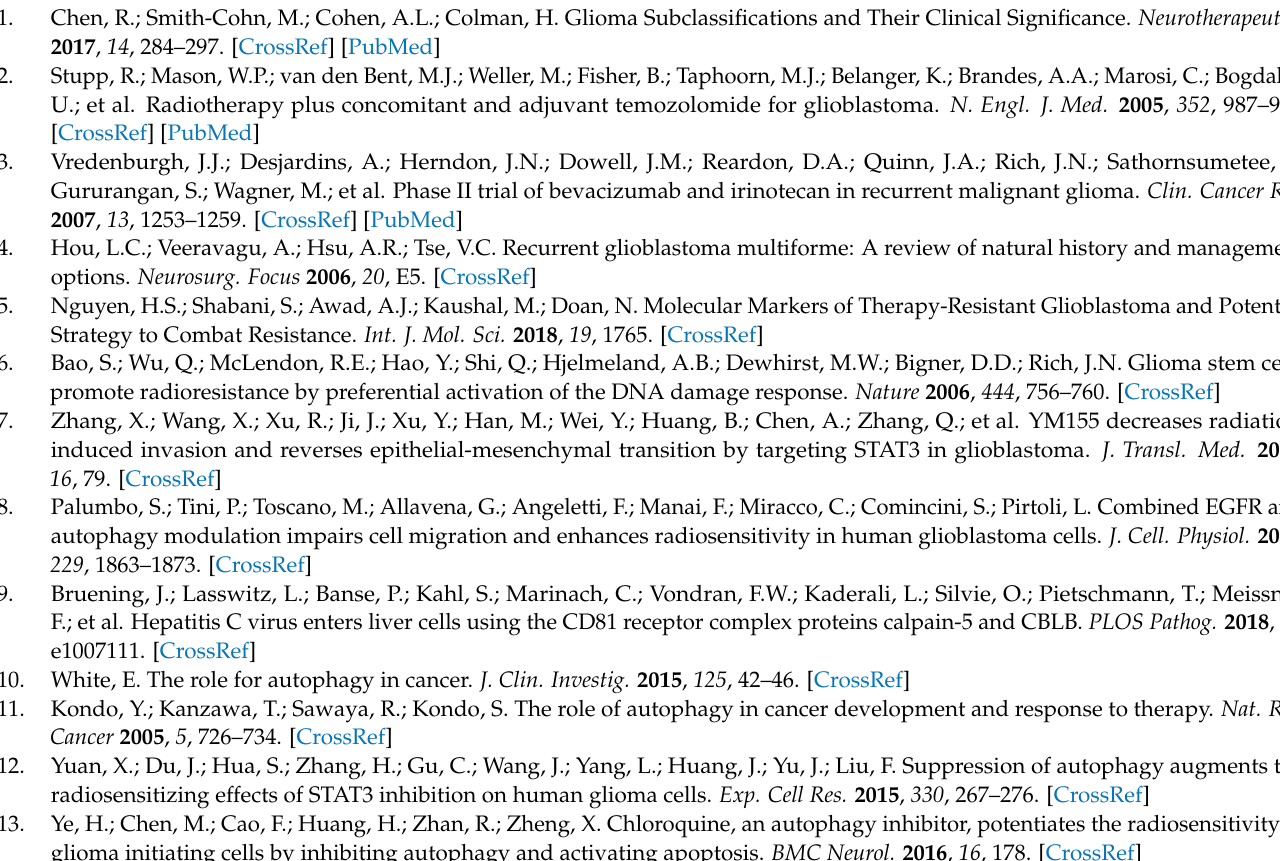
Figure S2. Suppression of CD81 reduced G2/M arrest in GBM cells exposed to